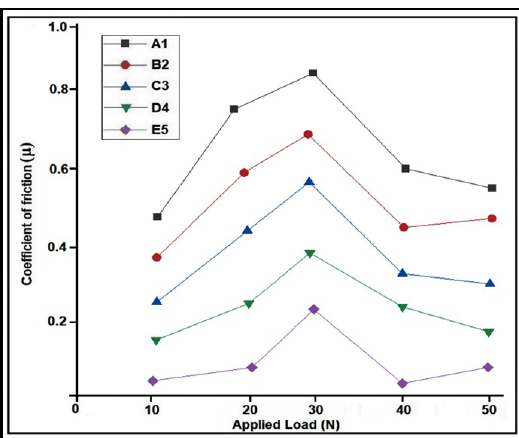
Figure 7. Coefficient of friction at 3m/s sliding velocity.